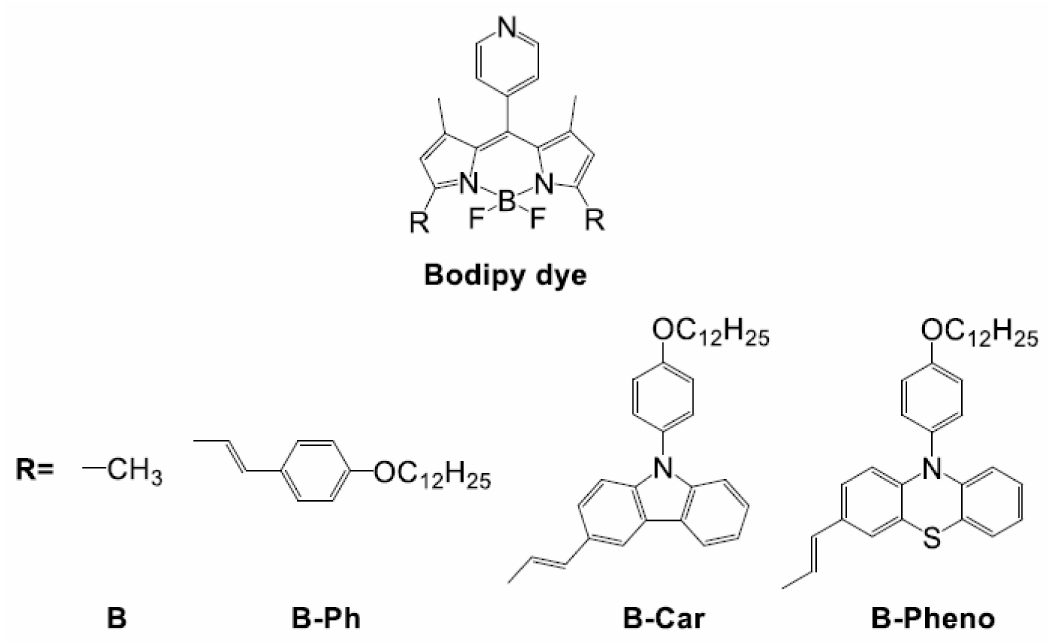
Figure 1. Chemical structure of BODIPY-sensitizer for this